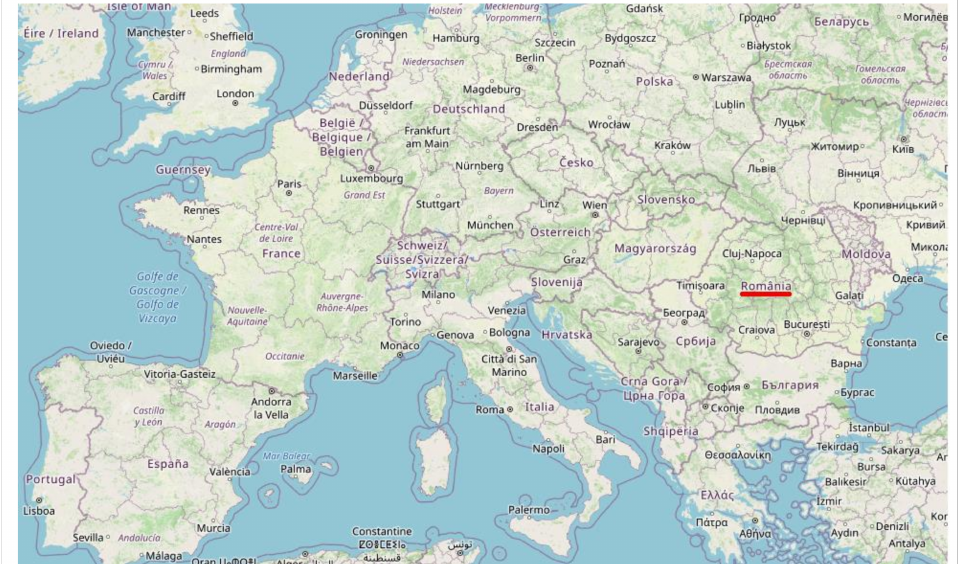
Figure 7. Europe map highlighting the territory (Romania) where the ArchTerr project pilot phase was